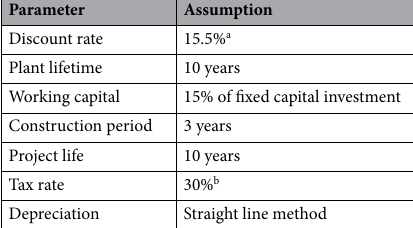
Table 2. Parameters used for discounted cash flow calculations. Sources: a26 , b36 .